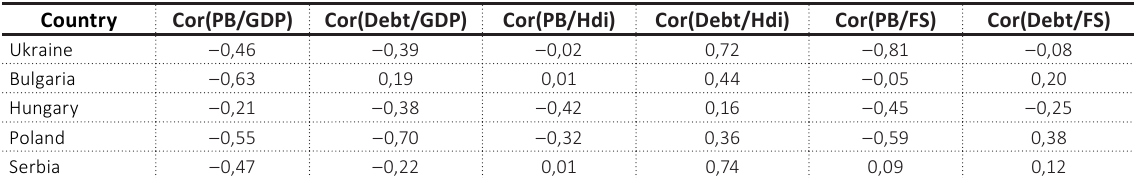
Table A6. Correlation matrix for Hypothesis 1 and Hypothesis 2